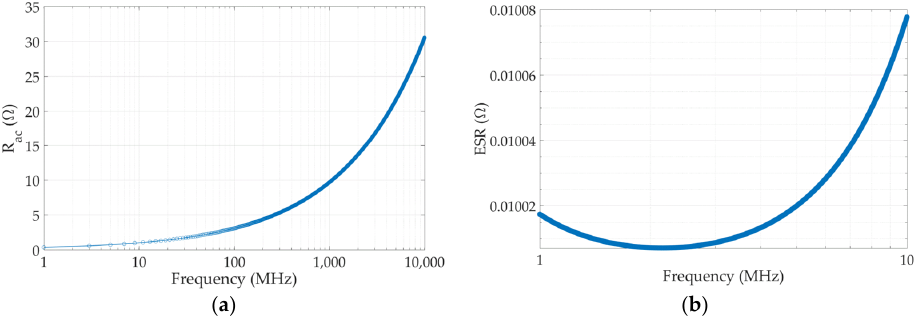
Figure 2. Variances at different frequencies for ( a ) AC resistance of the coupling coil and ( b ) equivalent series resistance, ESR, of the capacitor.